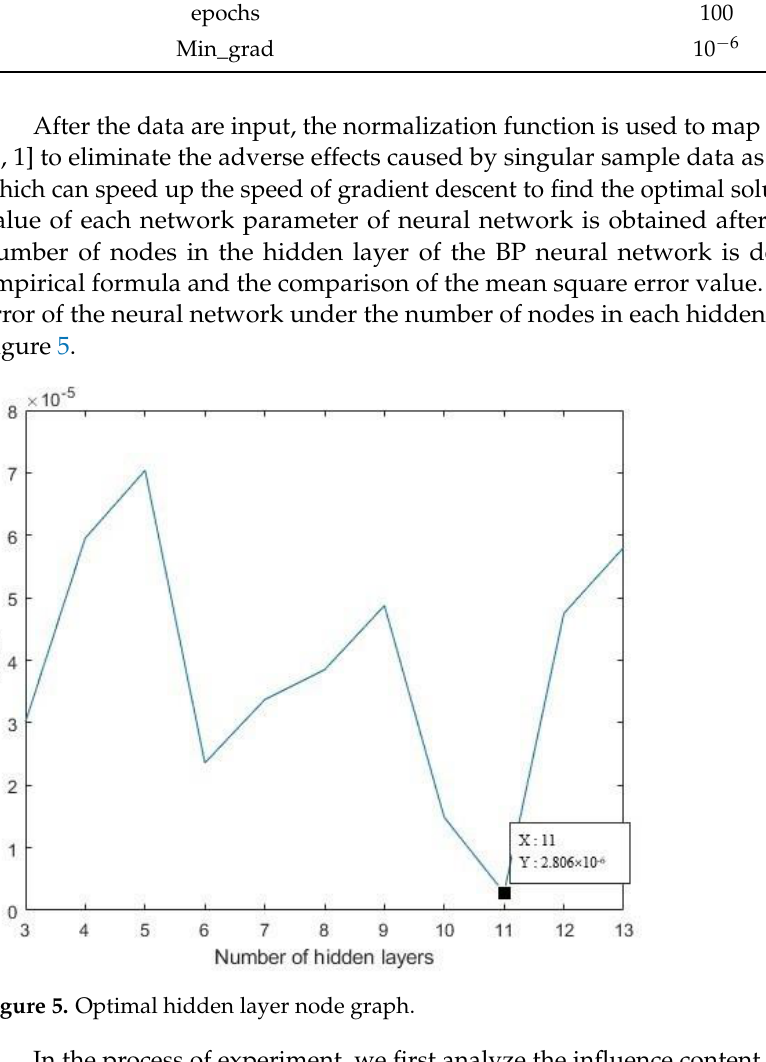
Table 2. BP network parameters.